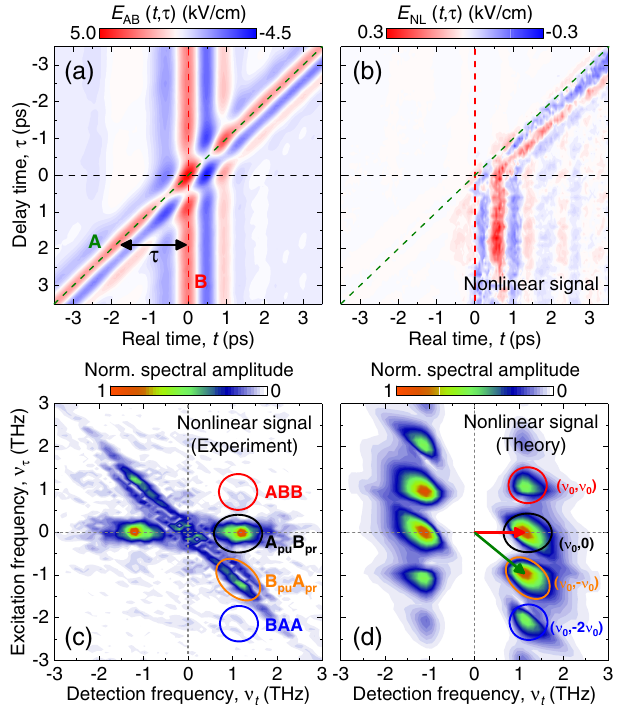
FIG. 4. (a) Contour plot of THz pulses A and B when simultaneously transmitted through the sample at room temper- ature. The THz electric field is plotted as a function of both the real time t and the delay time τ between the pulses. (b) Emitted ð t; τ Þ . The green and red dashed lines nonlinear THz field E NL indicate the position of the driving fields A and B, respectively, while the black dashed line indicates zero delay time. (c) Contour ð ν ; ν Þ spectrum, obtained by the 2D plot of experimental E t τ NL ð t; τ Þ signal field. (d) Contour Fourier transformation of the E NL ð ν ; ν Þ spectrum. The colored ellipses plot of the theoretical E t τ NL indicate the position of the nonlinear signals. The green and red arrows are the frequency vectors associated with THz pulses A and B, respectively. Note that ν 0 ¼ 1 . 17 THz is the soft-mode frequency. The grey dashed lines in panels (c) and (d) are the ν ¼ 0 and ν ¼ 0 t τ